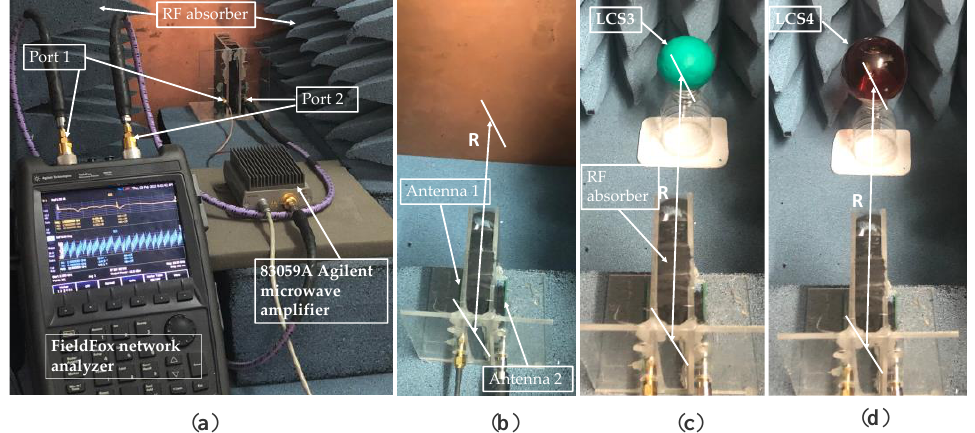
Figure 7. Measurement setup: ( a ) Whole measurement system; ( b ) Conducting plane measurement; ( c ) LCS 3 measurement; ( d ) LCS 4 measurement.